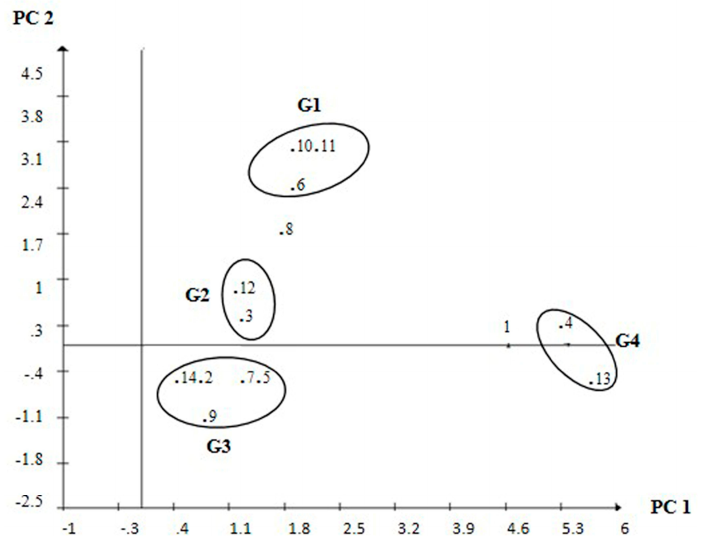
Figure 2. Pairwise score plot between the two first principal components (PC), based on the phenolic composition of skin extracts of different peanut genotypes. Clusters identified as G1, G2, G3 and G4. 1-BR 1, 2-LViPE-06, 3-Senegal 57422, 4-Tatu, 5-Florunner, 6-BRS 151 L7, 7-FM424B, 8-FM407B, 9-Porto Alegre, 10-L7 Bege, 11-Senegal 55437, 12-L50, 13-M407.424B,